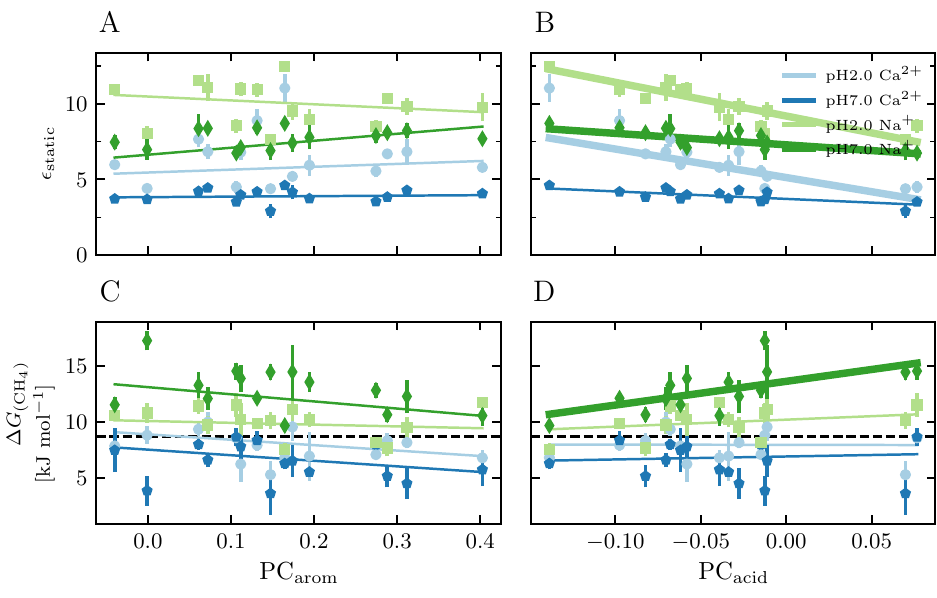
Figure 4. Static relative dielectric constant and free energy of inserting a methane molecule of the standard humic substances as a function of the principal components. Each point represents the average over four independent simulations with error bars representing the standard error. Each plot has a fitted line using linear regression, which is presented as a tick line if the R 2 is larger than 0.6. ( A , B ) dielectric constant and ( C , D ) free energy of inserting a methane probe into different humic substances models as a function of their PC arom and PC acid